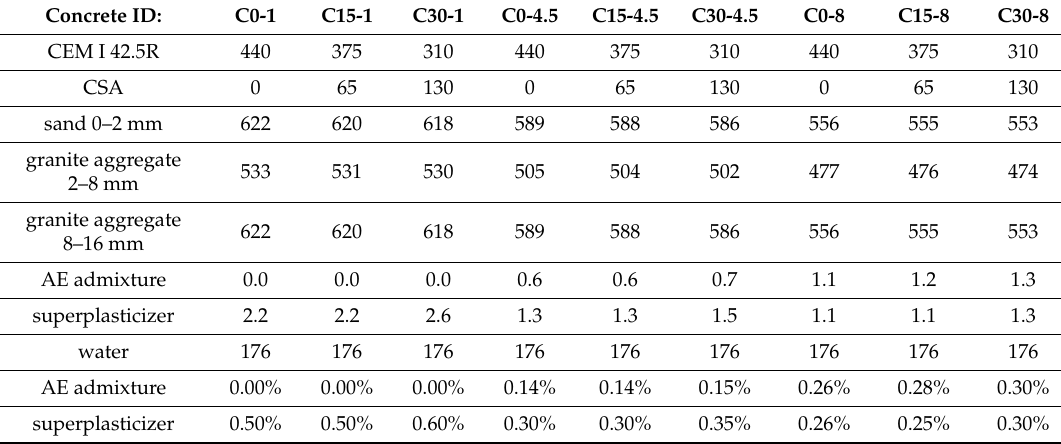
Table 3. Recipes of concrete mixes [kg / m 3 ].